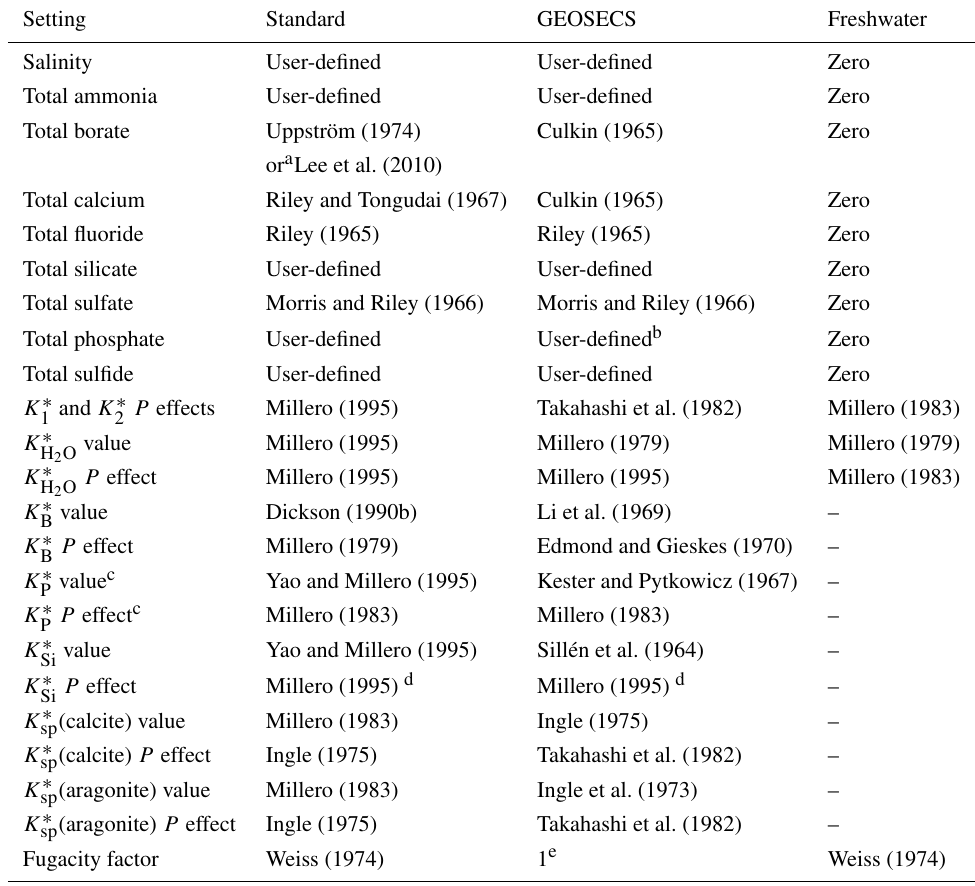
Table 2. Parameterisations that vary depending on the case of the selected carbonic acid constants (Table 1). P : pressure. Setting